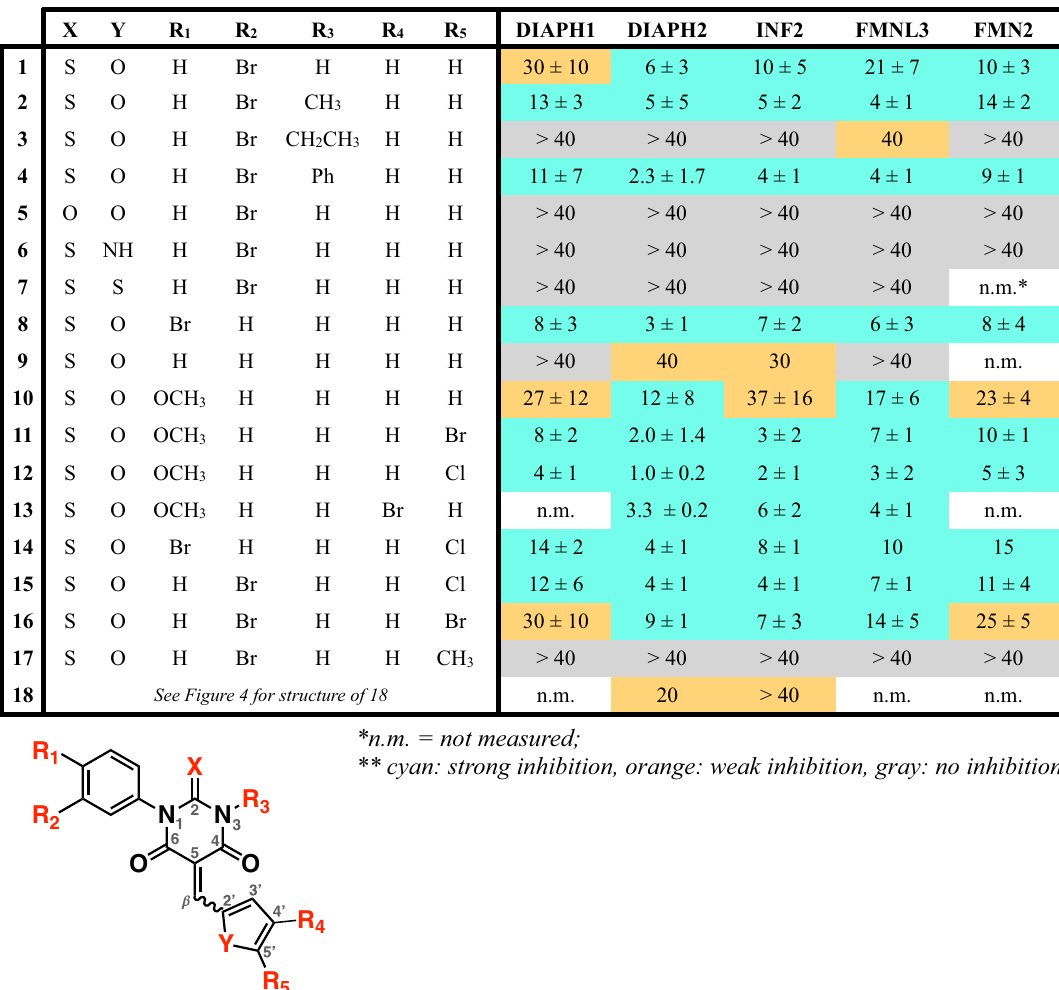
Table 1. IC50 values (μM) for SMIFH2 and 17 analogs tested against five human